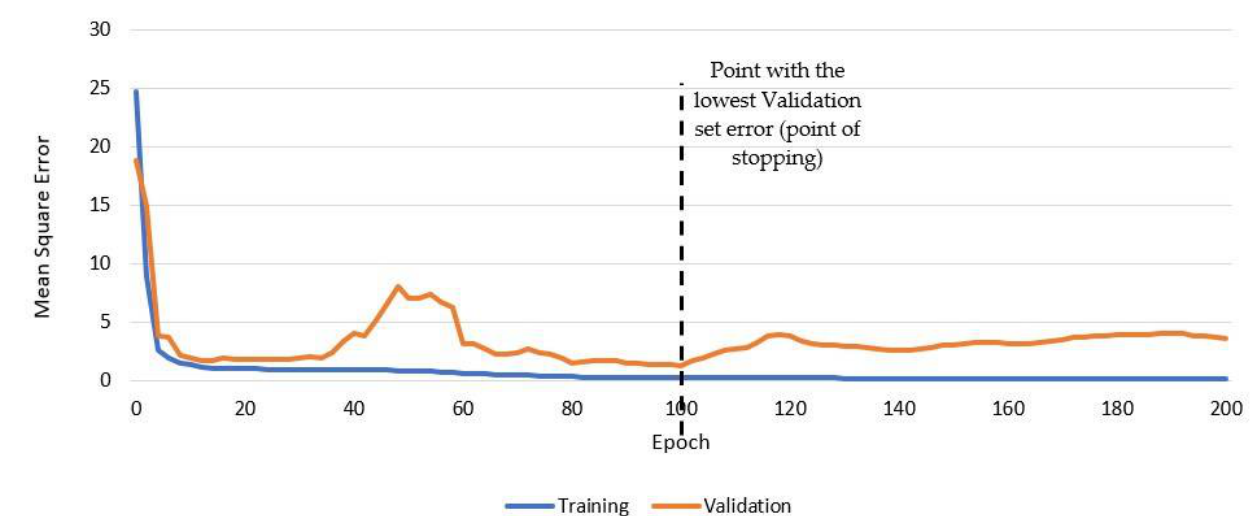
Figure 4. The training set and validation set error during the training process for an ANN with 3 hidden layers, 3 neurons per hidden layer and employs the tanh activation function.